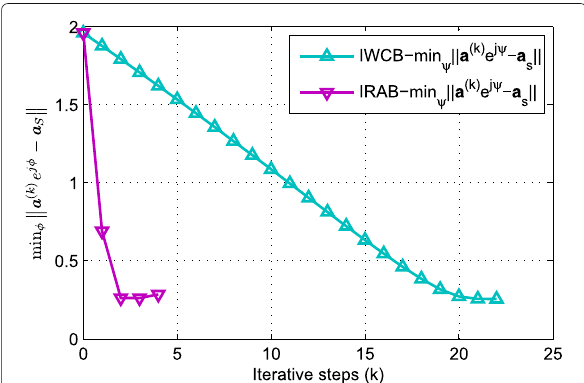
Fig. 5 The convergence properties of IRAB and IWCB: steering vector error versus iterative steps